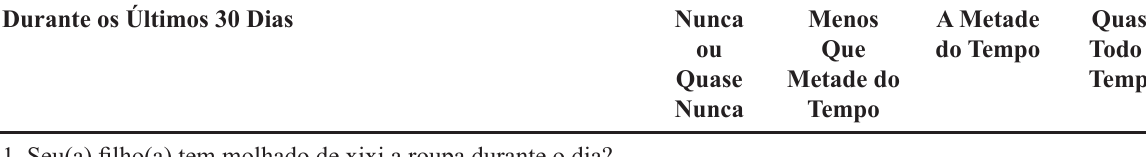
Table 1 – Portuguese Brazilian version of the Dysfunctional Voiding Symptom Score. Durante os Últimos 30 Dias Nunca